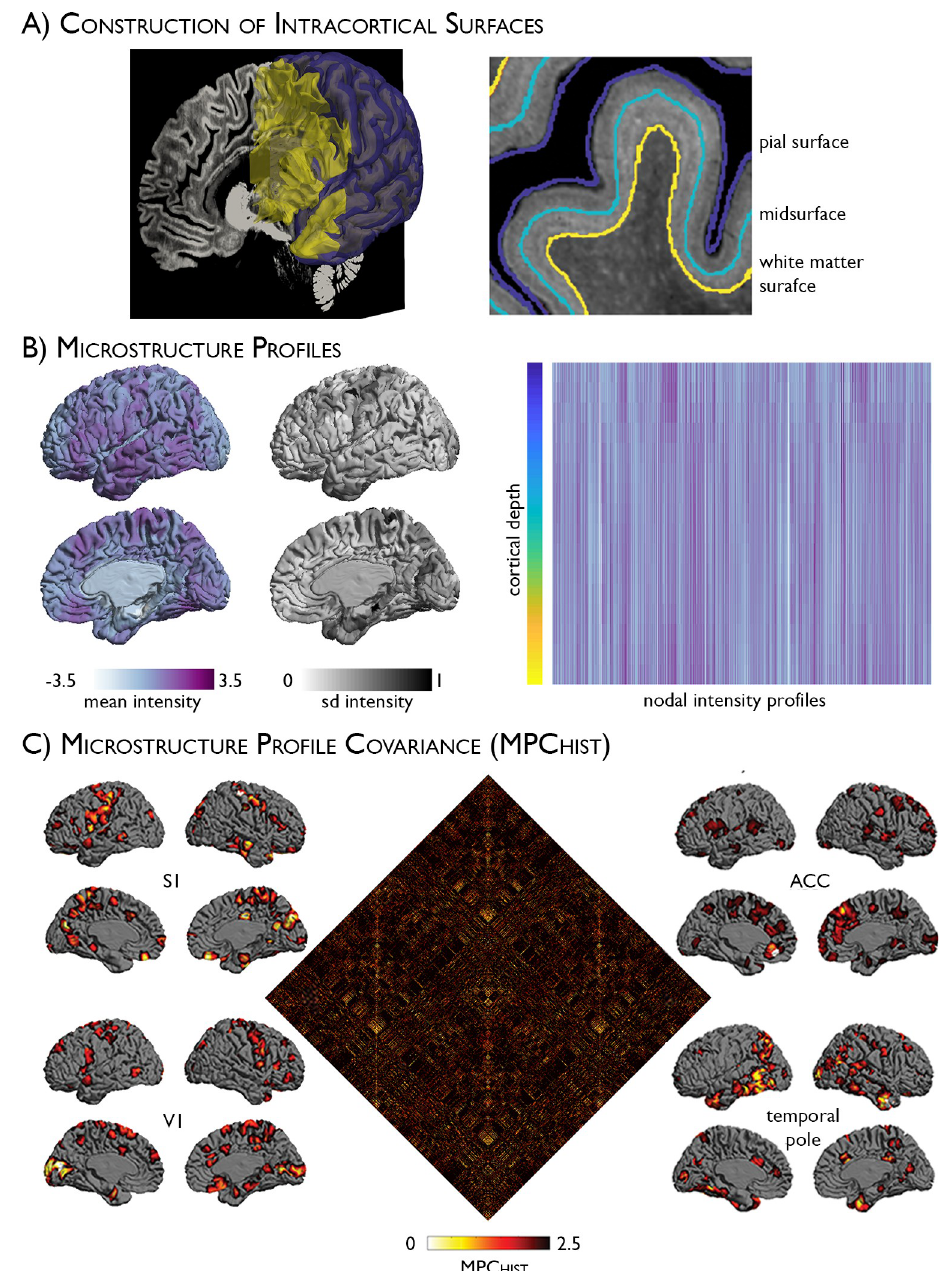
Fig 1. Histology-based MPC HIST analysis. (A) Pial (purple) and WM (yellow) surfaces displayed against a sagittal slice of the BigBrain (left) and with the midsurface (blue) in magnified view (right). (B) Mean and SD in residual intensity at each node are displayed on the cortex (left). Cortex-wide intensity profiles were calculated by systematic intensity sampling across intracortical surfaces (rows) and nodes (columns). (C) The MPC HIST matrix depicts node- wise partial correlations in intensity profiles, controlling for the average intensity profile. Exemplary patterns of microstructural similarity from S1, ACC, V1, and the temporal pole. Seed nodes are shown in white. Histological data is openly available as part of the BigBrain repository (https://bigbrain.loris.ca/main.php). ACC, anterior cingulate cortex; HIST, histology-based; MPC, microstructure profile covariance; S1, primary somatosensory; V1, primary visual; WM, white